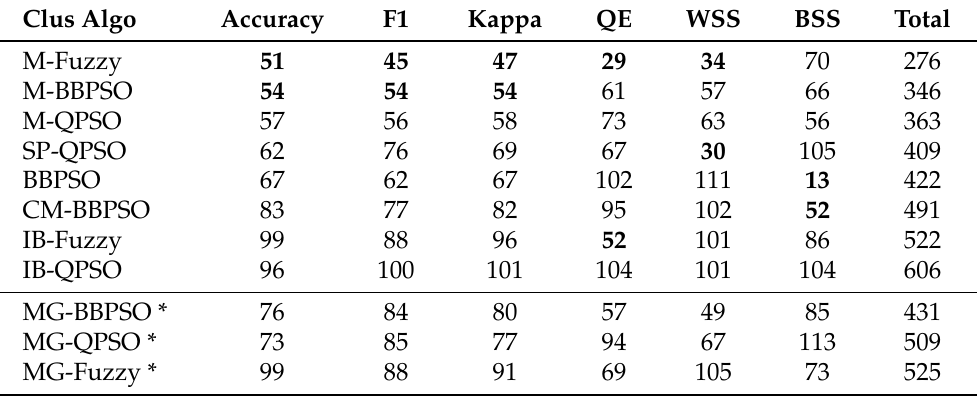
Table 5. Sum rank of algorithms based on performances on 6 metrics on all datasets with best two sum rank values presented in bold.